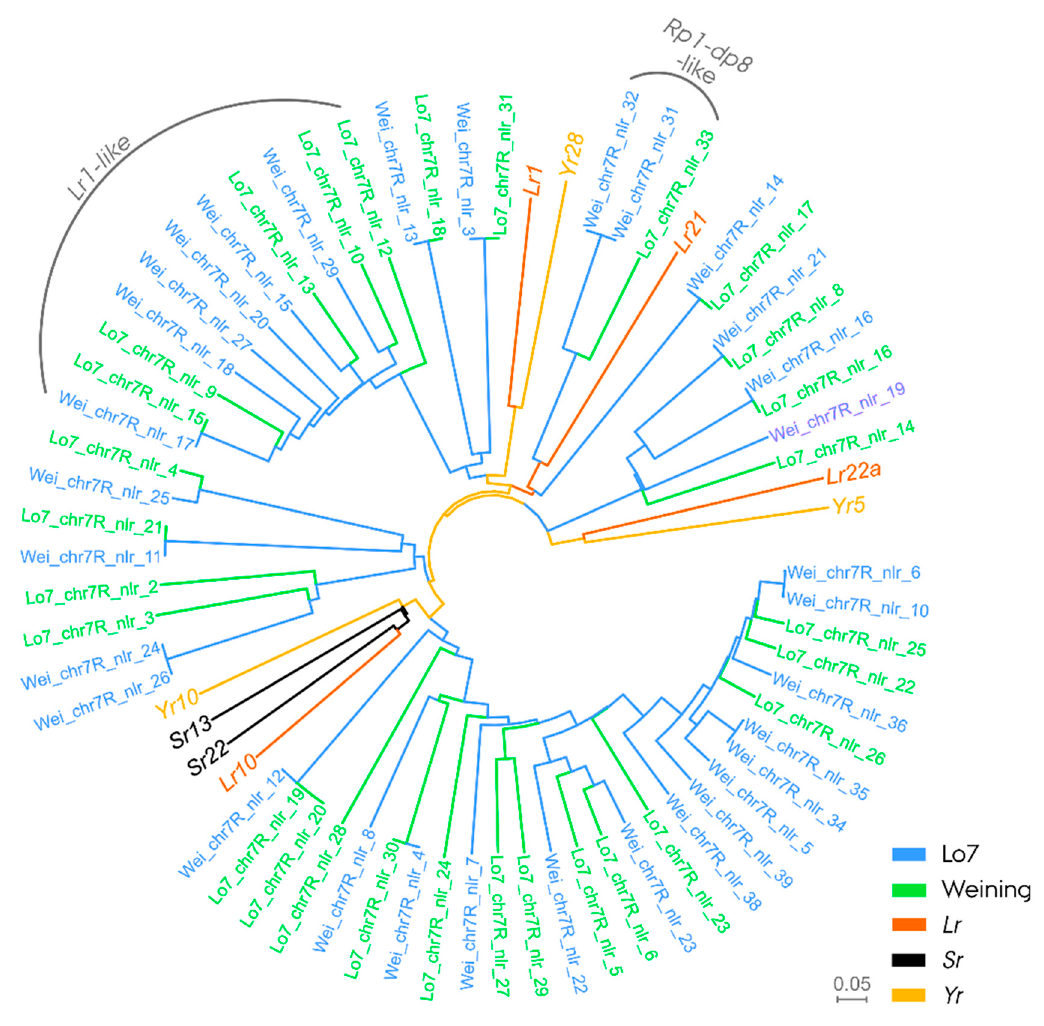
Figure 4. Phylogenetic relationship of nucleotide-binding leucine-rich repeat (NLR) genes in a leaf rust resistance association region on rye ( Secale cereale L.) chromosome arm 7RS in the reference genomes Lo7 and Weining. The tree was constructed using the central NB-ARC domain sequence. Panels of known wheat leaf rust ( Lr ), stripe rust ( Yr ) and stem rust ( Sr ) genes are included as